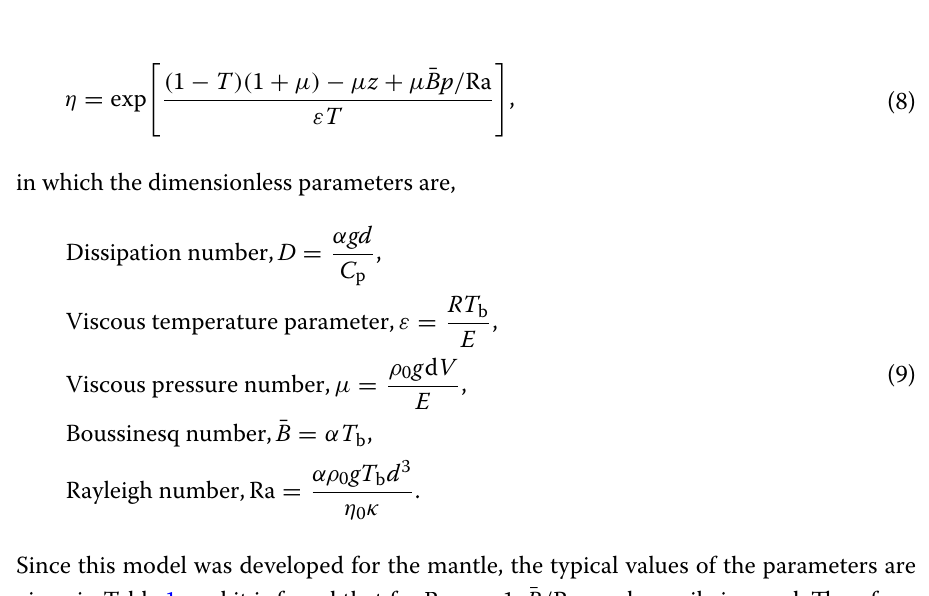
Table 1 Typical parameter values for mantle convection with variable viscosity Parameter Symbol Value Mantle depth d 3 × 10 6 m Thermal expansion coefficient α 2 × 10 − 5 K − 1 Reference density ρ 0 4 × 10 3 kg m − 3 Gravitational acceleration g 10 m s − 2 Temperature at the top of the mantle T s 300 K Temperature at the base of the mantle T b 3000 K Temperature difference (cid:31) T 2700 K Thermal conductivity k 4 W m − 1 K − 1 Specific heat at constant pressure C p 10 3 J kg − 1 K − 1 Activation energy E 300–525 kJ mol − 1 Activation volume V 6 × 10 − 6 m 3 mol − 1 Gas law constant R 8.31 J mol − 1 K − 1 Viscous rate constant A 10 5 MPa − 1 s − 1 Thermal diffusivity κ 1 × 10 − 6 m 2 s − 1 Rayleigh number Ra 10 7 − 10 9 Viscous temperature parameter ε 0.042 − 0.083 Viscous pressure number µ 1.2 − 2.4 Boussinesq number ¯ B 0.06 Dimensionless surface temperature θ 0 0.1 Dissipation number D